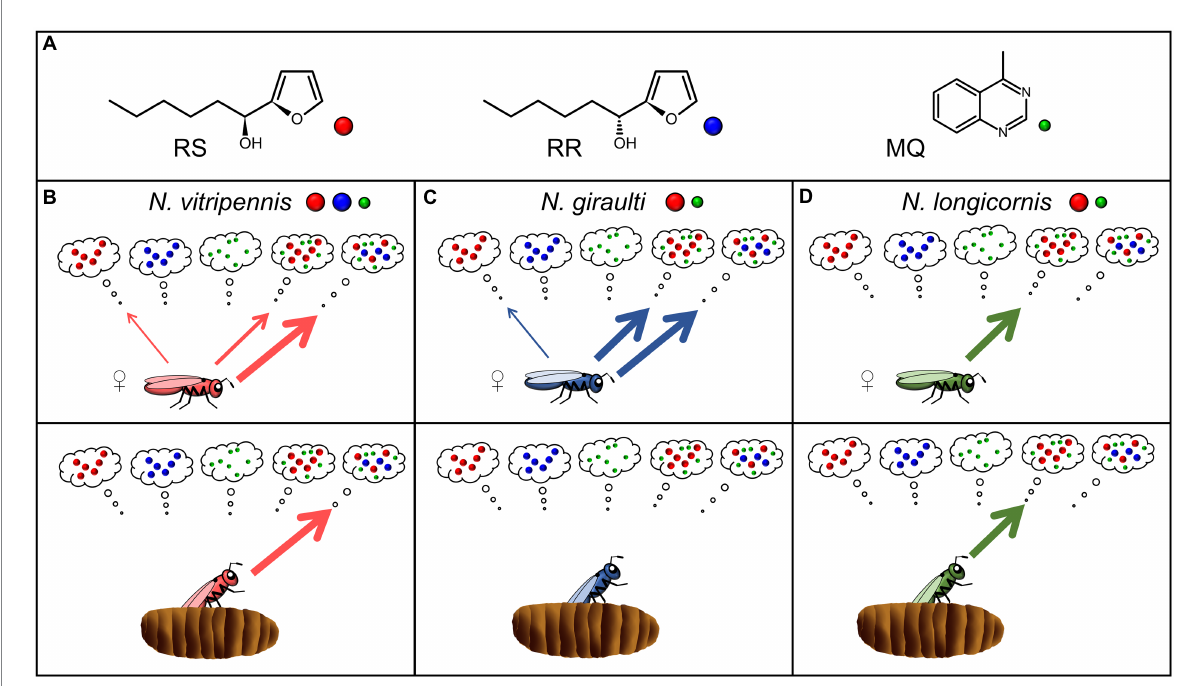
FIGURE 1 (A) Structures of the components of the male abdominal sex pheromones in the genus Nasonia (4 R ,5 S )-5-hydroxy-4-decanolide (RS), (4 R ,5 S )-5- hydroxy-4-decanolide (RR), and 4-methylquinazoline (MQ). (B–D) Scheme summarizing the female responses of the hitherto investigated species Nasonia vitripennis (Niehuis et al., 2013; Ruther et al., 2014), Nasonia giraulti (Niehuis et al., 2013; Ruther et al., 2014), and Nasonia longicornis (this study) to the male sex pheromone components and combinations thereof. Pheromone composition of the different species is indicated by colored dots near the species names. The upper panels show the response of 2-d-old virgin females excised from the hosts, the lower panels refer to females collected at the moment of emergence from the host (for more details see